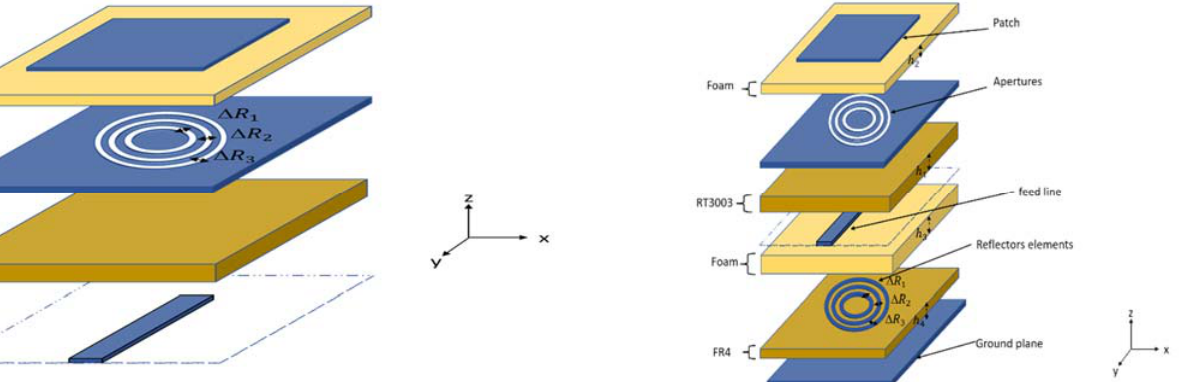
Fig 7. Aperture stacked patch antenna with reflectors patch